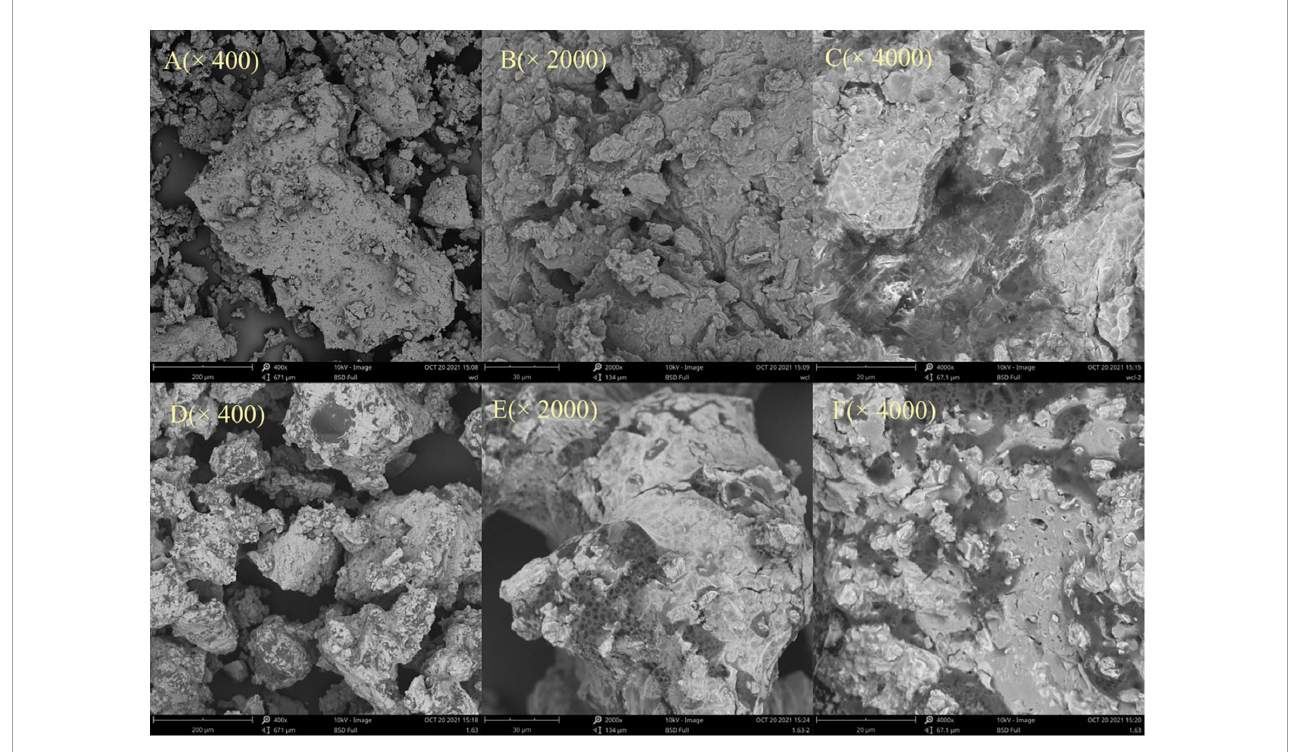
FIGURE3 Scanning electronic micrographs of soluble dietary fiber (SDF) from untreated adlay bran (A–C) and SDF from steam explosion (SE)-treated adlay bran (D–F) . Magnifications are 400 × , 2,000 × , and 4,000 ×